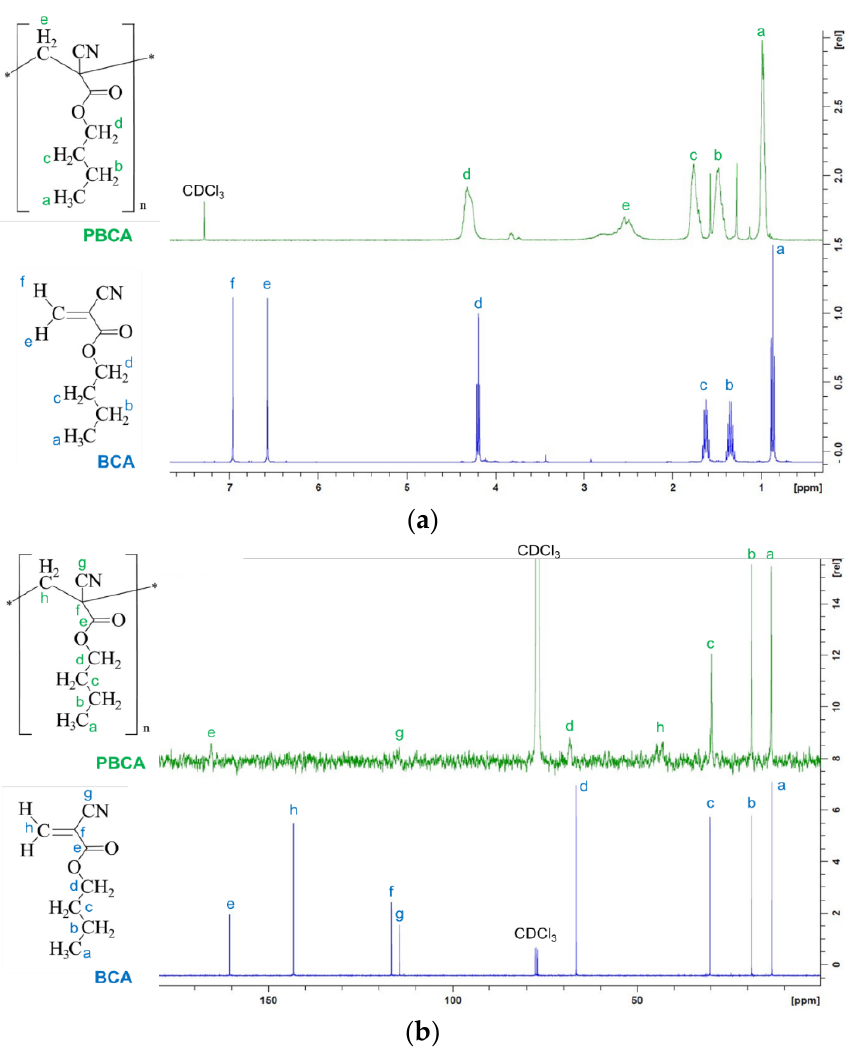
Figure 1. ( a ) 1 H and ( b ) 13 C NMR spectra of BCA and PBCA powders measured in deuterated chloroform (CDCl 3 ).